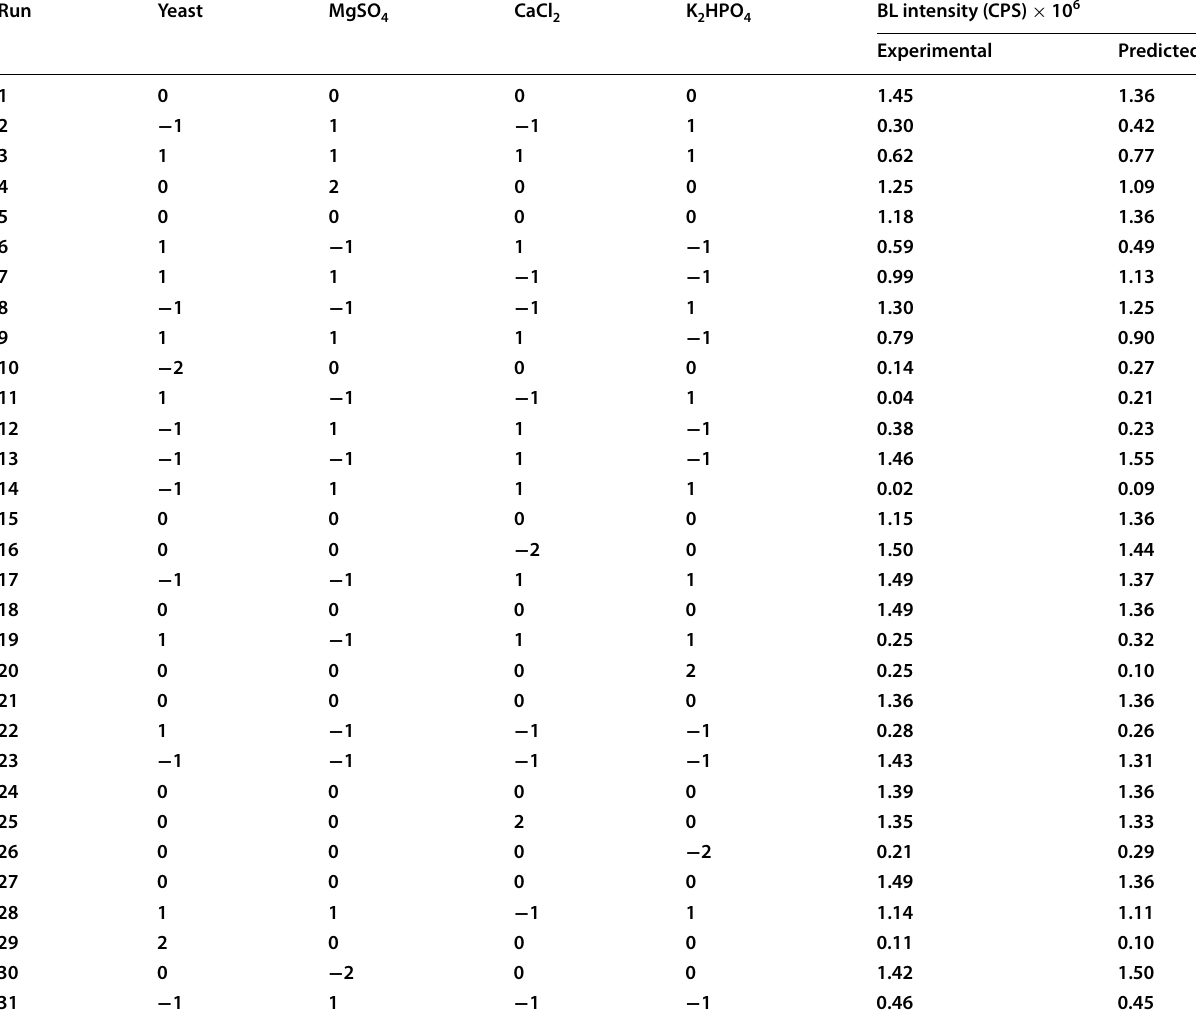
Table 7 CCD matrix of variables influencing V. sp. 6HFE BL intensity